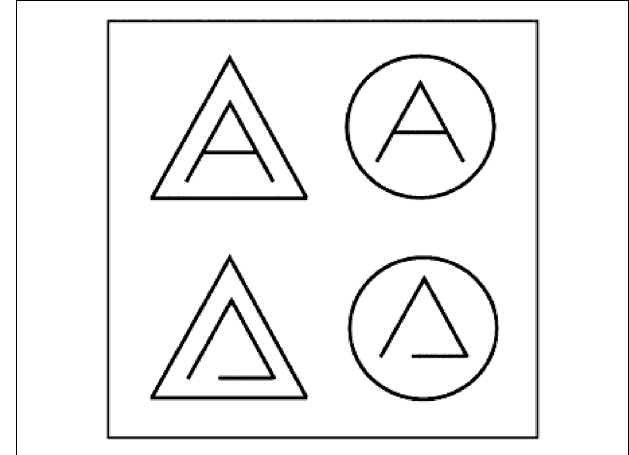
FIGURE 3 | Letters (top) and pseudo-letters (bottom) in congruent (left) and incongruent (right) surroundings, as used in our flanker studies. See also Fernandes etal. (2014) for similar